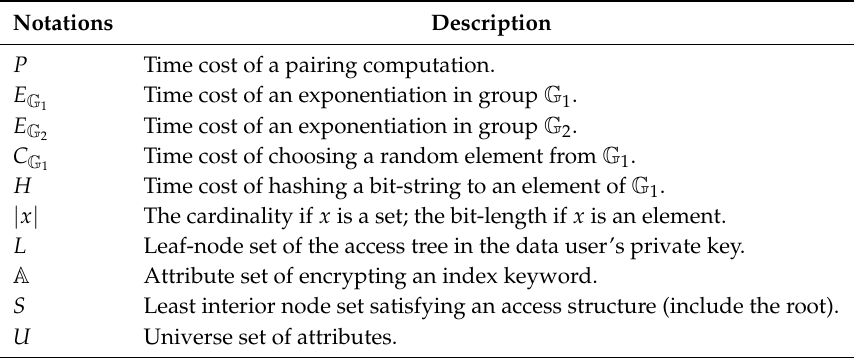
Table 1. Notations used in complexity